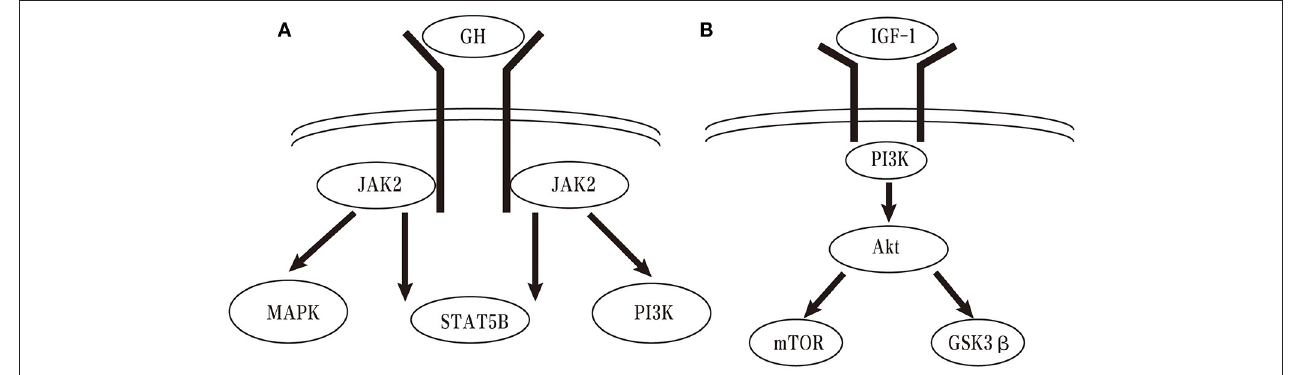
FIGURE 2 | Schematic drawing of GH and IGF-1 signaling